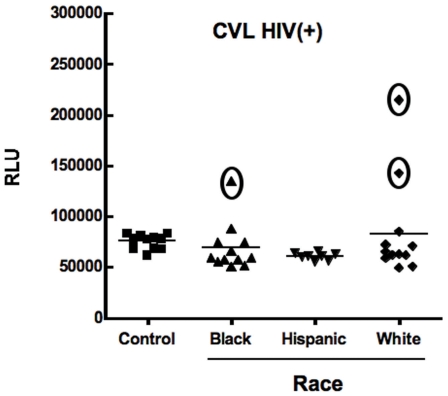
Determination of the presence of infectious HIV-1 in CVL from HIV(+) women.HIV(+) CVL from 32 patients were diluted 1∶4 and added directly to TZM-bl cells. The assay was terminated 48h post-infection and HIV-1 infection was quantified by measuring luciferase reporter gene activity using a luminometer and expressed as relative light units (RLU). Each data point in graph represents one individual patient. In the Control (media only) column, each point represents replicate wells. When comparing Controls with the CVL samples (TZM-bl cells incubated with CVL), 3 out of 32 showed RLU levels at least 2-fold above background indicating that these 3 CVL contained infectious HIV-1 which trans-activated the LTR-driven reporter gene.